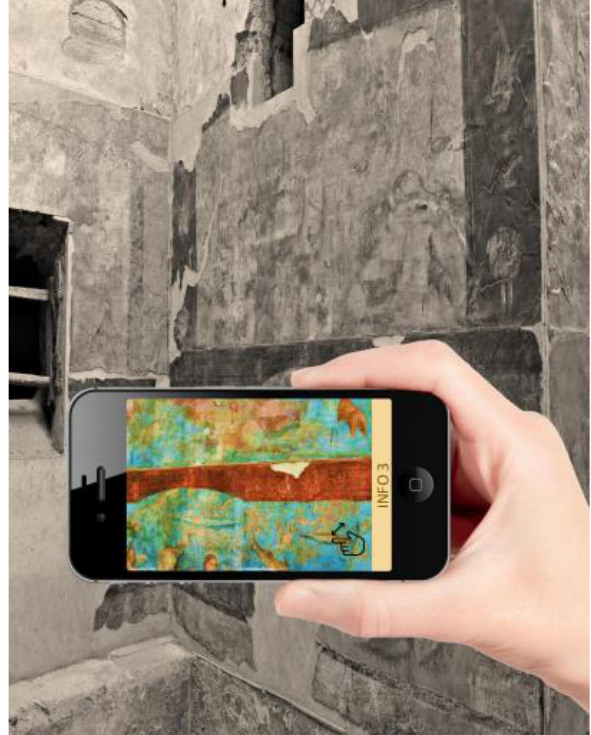
Figure 12. Example of Augmented Reality. The app can recreate the original features, allowing to compare the old and the actual perception.